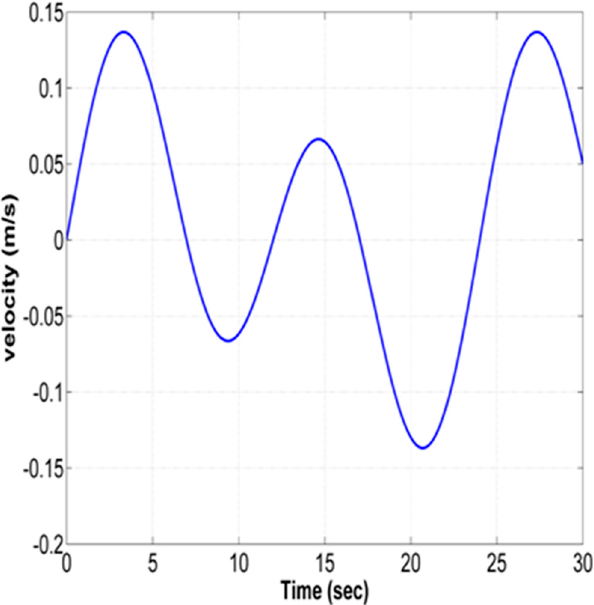
Figure 17. Wave disturbance.